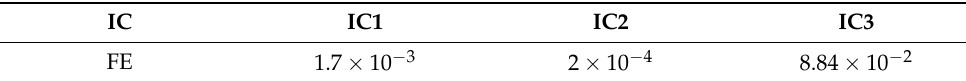
Table 1. Fuzzy entropy of different signal components.